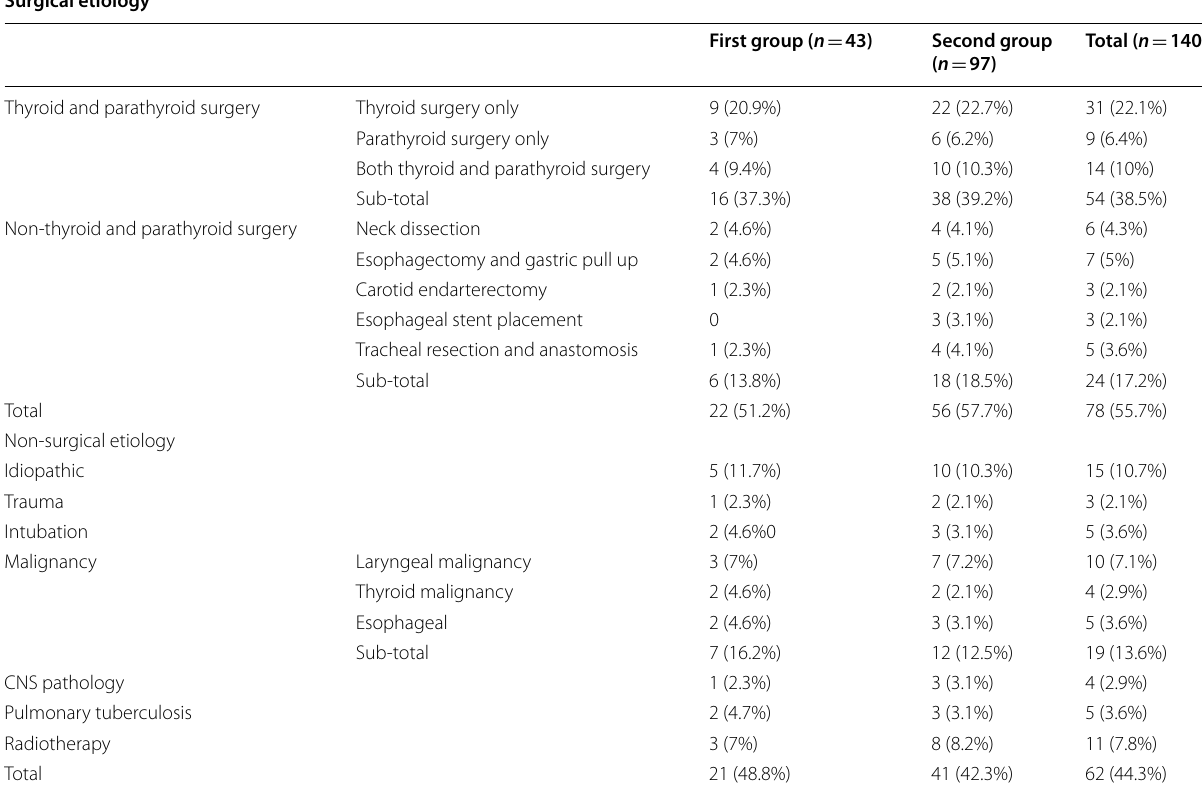
Table 2 Surgical and non-surgical etiology of BVCP Surgical